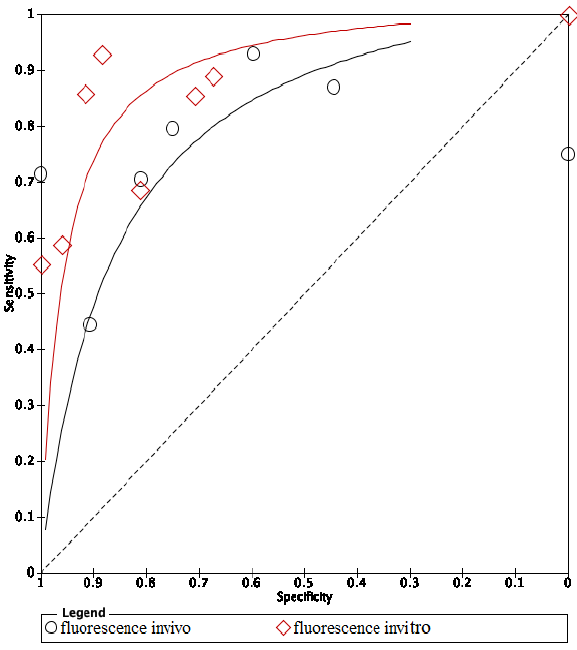
Figure 7. sRoc curves of photographic visual examination on occlusal surfaces. The area under the curve (AUC) of in vivo fluorescence was higher in in vitro fluo- rescence. On the other hand, methods using in vivo visual photographic examination had lower AUC of in vitro visual photographic examination (Figures 8 and 9).